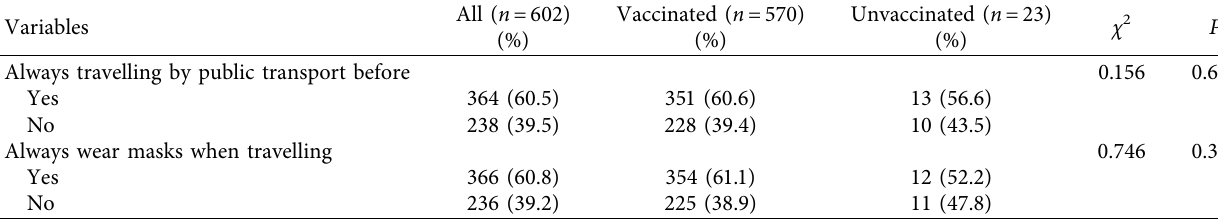
Table 2: Participant behaviours during the COVID-19 pandemic.